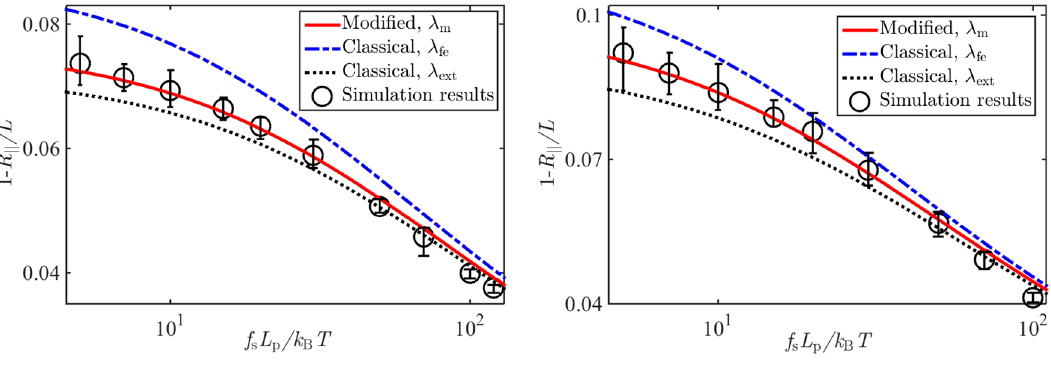
Figure 5. Comparison of Brownian dynamics simulations and theoretical predictions on the relative average extension of a WLC under stretching and confinements of square tubes of sizes ( a ) H w / L p = H h / L p = 0.2, ( b ) H w / L p = H h / L p = 0.3, ( c ) H w / L p = H h / L p = 0.4, and ( d ) H w / L p = H h / L p = 0.6.